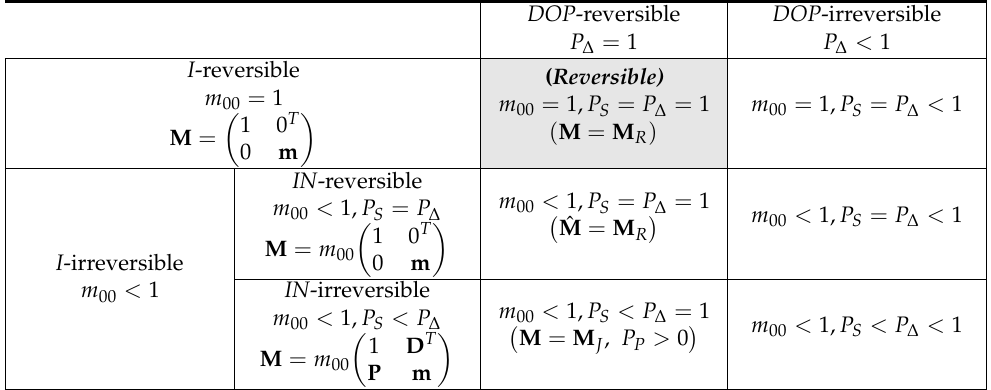
DOP -reversible DOP -irreversible P ∆ = 1 P ∆ <